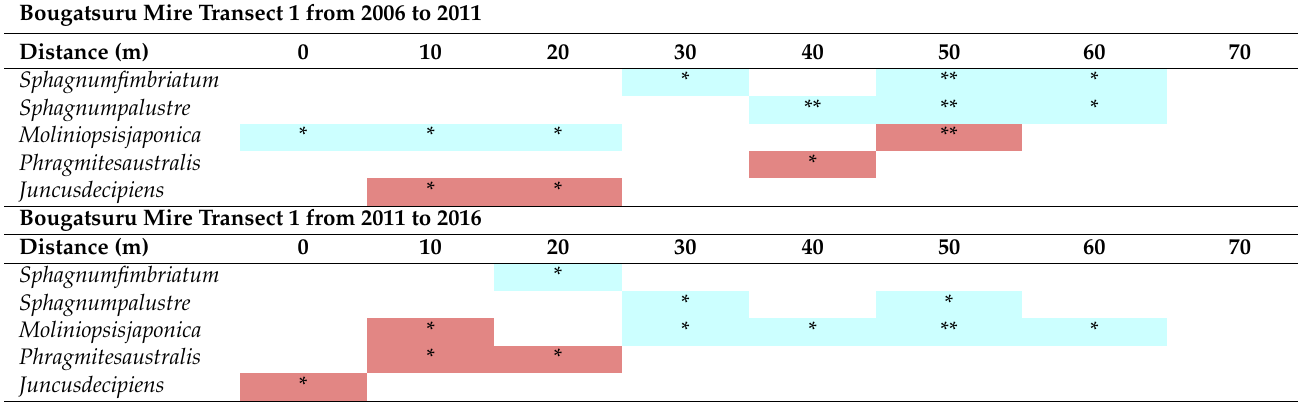
Table 2. Significance levels of difference of coverage of abundant species between 2006 and 2011 and between 2011 and 2016 at water environment monitoring sites along Bougatsuru transect 1 (Bougatsuru transect 1). Five 1 × 1 m 2 quadrats of both sides of each water environment monitoring site (one side at both end sites) were assigned to each site. Significance of difference was tested by Wilcoxon test. Red-colored cells show the increase in coverage and blue-colored cells show the decrease in coverage from the beginning to the end of each